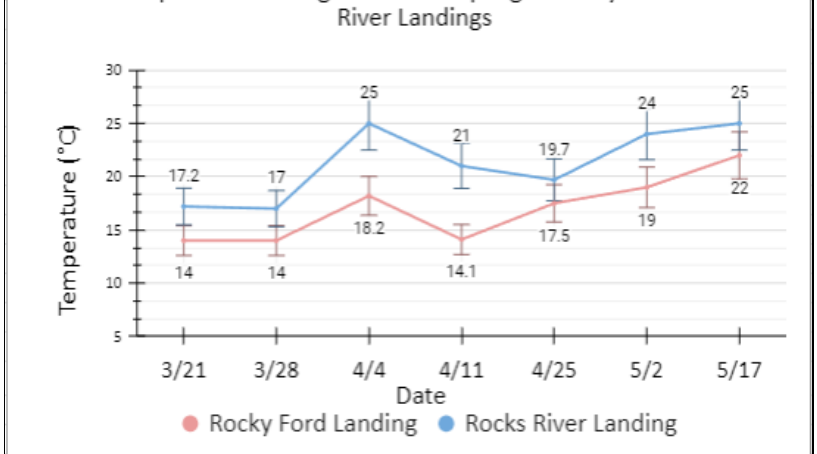
Figure 8. Water Quality — Water Temperature in Degree Celsius from March – May 2022.